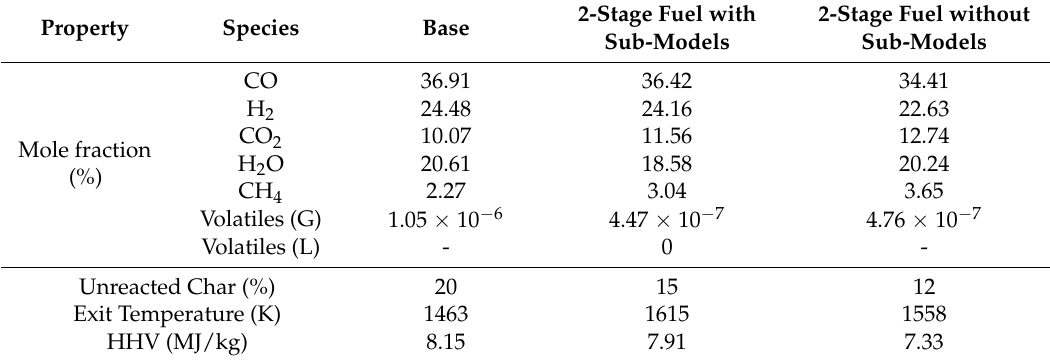
Table 9. Effect of fuel-redistribution on syngas composition and exit temperature with and without condensation and re-vaporization